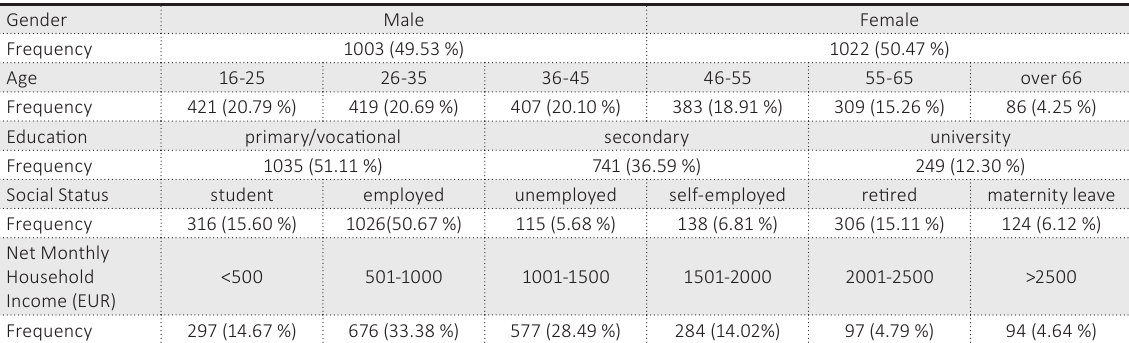
Table 1. Socio-demographic data